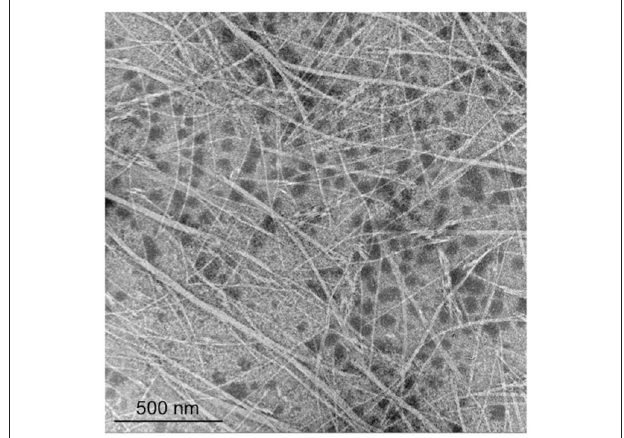
FIGURE 1 | Morphology of phage ϕ OH3. Shown are transmission electron micrographs of inovirus ϕ OH3 negatively stained with 2% (wt/vol) potassium phosphotungstate (pH 7.0). The scale bar is